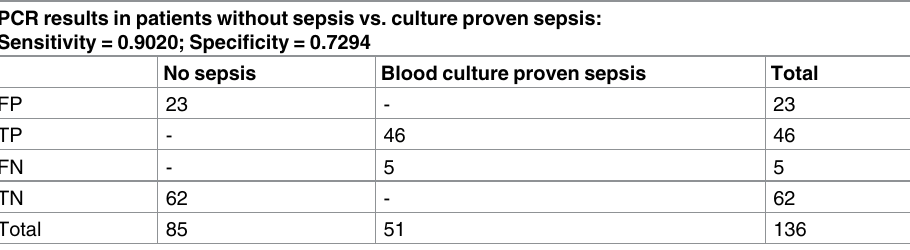
Table 4. Comparison of SeptiFast MGRADE PCR and blood culture results.